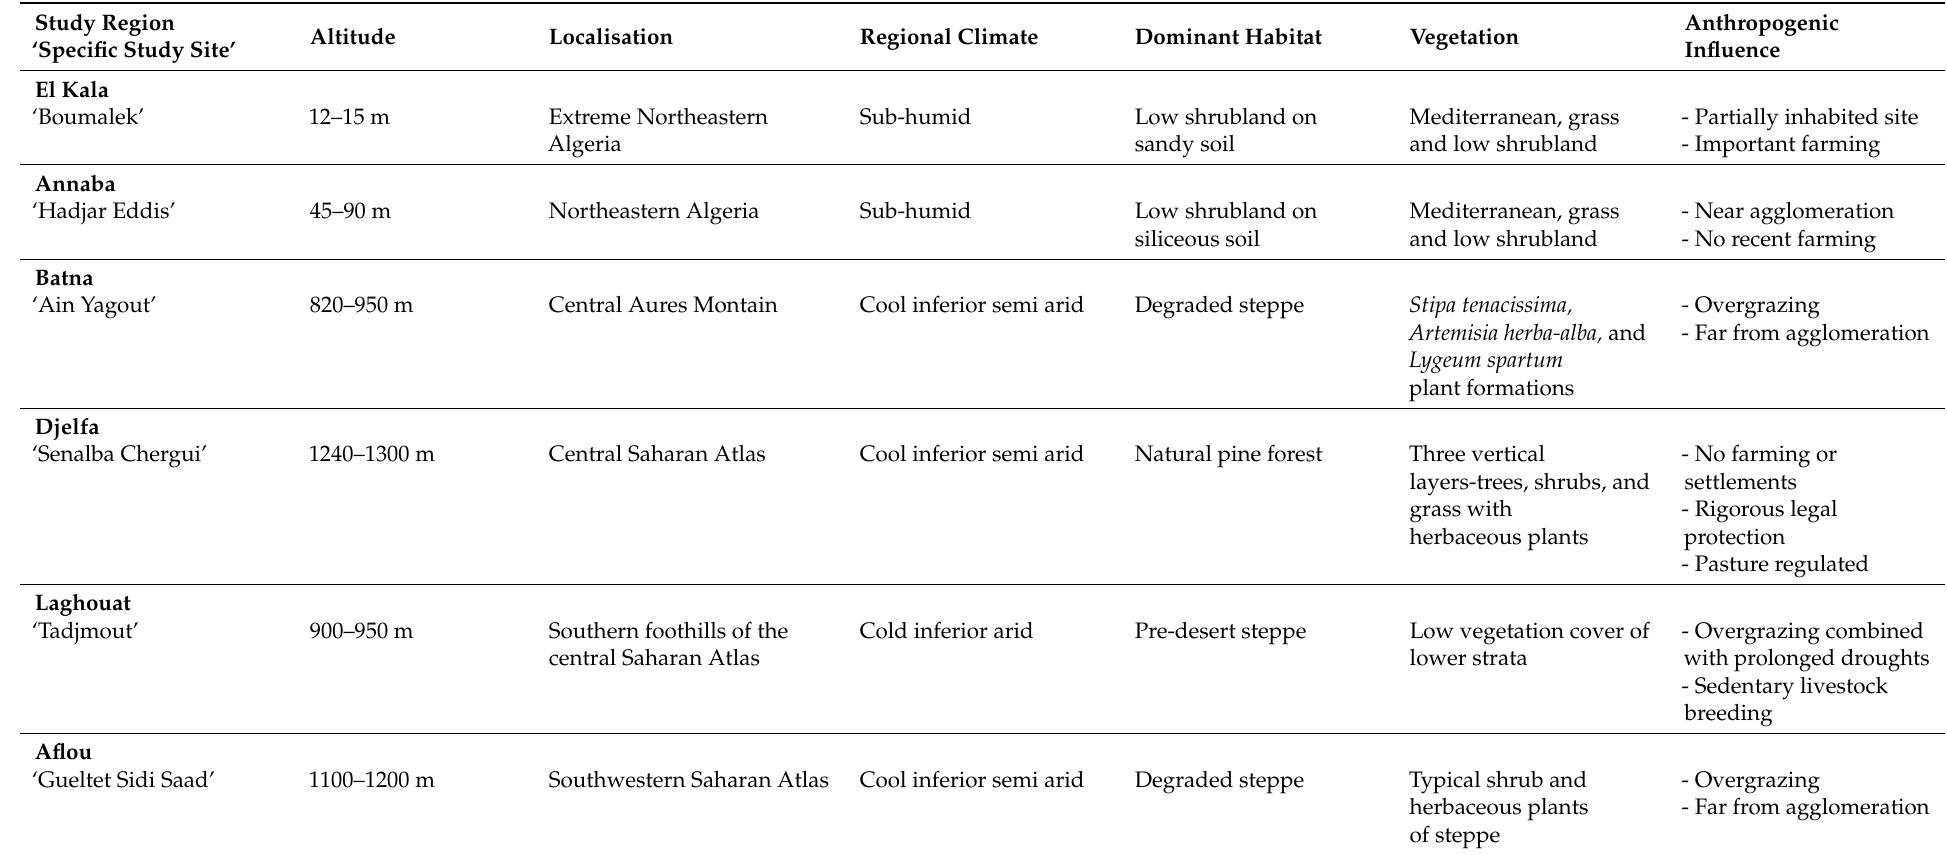
Table 1. Characterization of studied